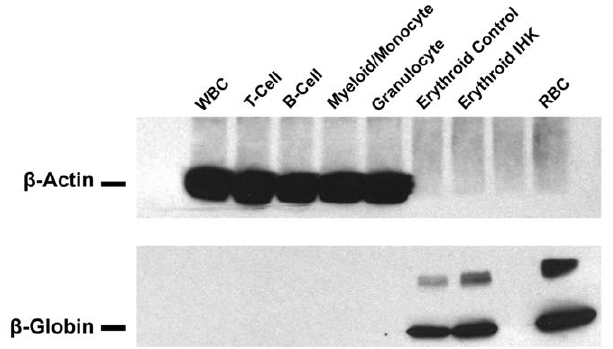
Figure 4. IHK-transduced CD34 + cells show b -globin expression only in erythroid cells. Thirty m g of total protein from IHK-transduced CD34 + cells differentiated into T-cells, B-cells, myeloid/monocytes, and granulocytes and 100 ng of total protein from non-transduced control or IHK-transduced CD34 + cells differentiated into erythrocytes were subjected to western blot using antibodies specific for b -globin and b - actin.